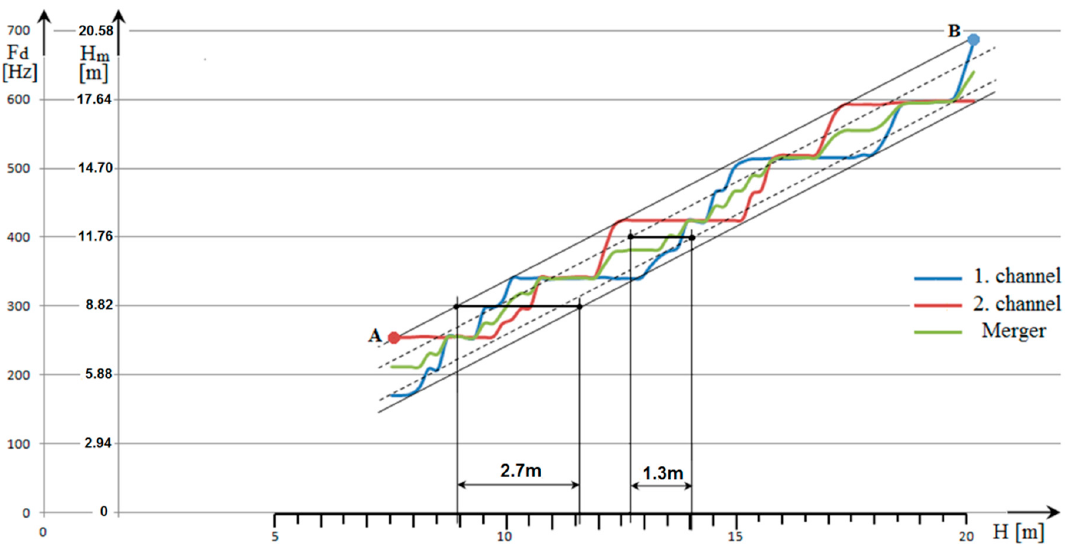
Figure 6. Measuring results.